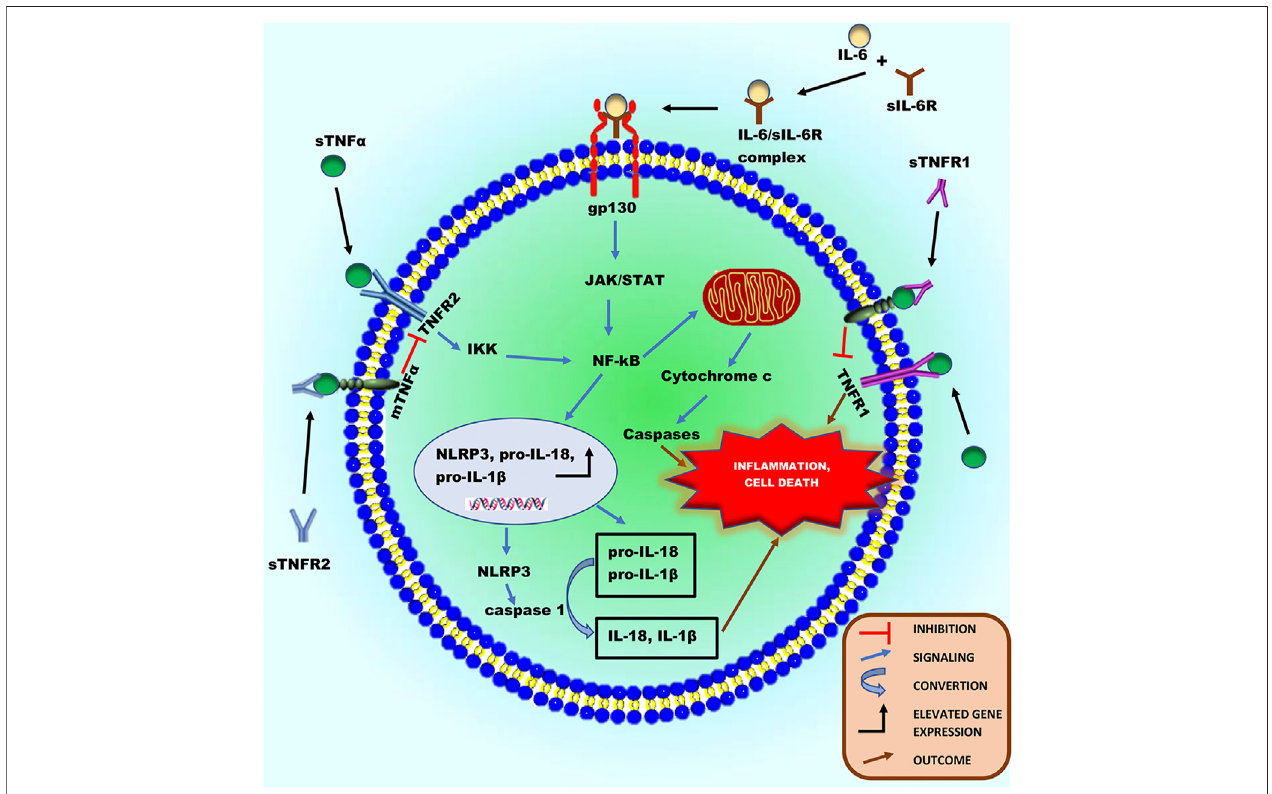
FIGURE 3 | Schematic illustration of the in fl ammatory roles of ADAM17 ’ s substrates, sTNF α and sIL-6R in a cardiac cell during chronic catecholamine stress. Following the proteolytic processing of ADAM17, sTNF α and IL-6 can bind to TNFR1/2 and sIL-6R, respectively activating downstream signaling cascades. Activated TNFR1 can directly induce in fl ammation and programmed cell death. The activation of TNFR2 can cause it to interact with the I κ B kinase (IKK) complex resulting in the phosphorylation of I κ B, thereby activating NF- κ B. Also, the IL-6/sIL-6R complex formed from IL-6 binding to sIL-6R can directly activate the ubiquitously expressed glycoprotein-130 (gp130), thereby activatingNF- κ B. Activated NF- κ B can either migrates into thenucleus or mitochondria. In thenucleus, it encodes genes of proin fl ammatory cytokines (pro-IL-18 and pro-IL-1 β ) and NLRP3, increasing their protein expression. NLRP3 in fl ammasome can activate caspase 1, which in turn cleaves pro- IL-1 β and pro- IL-18 to release their soluble forms, to induce necrosis and in fl ammation in cardiac cells. Additionally, in the mitochondria, activated NF- κ B can stimulate intrinsic apoptotic pathways via releasing cytochrome c, which triggers caspase cascades resulting in programmed cell death and in fl